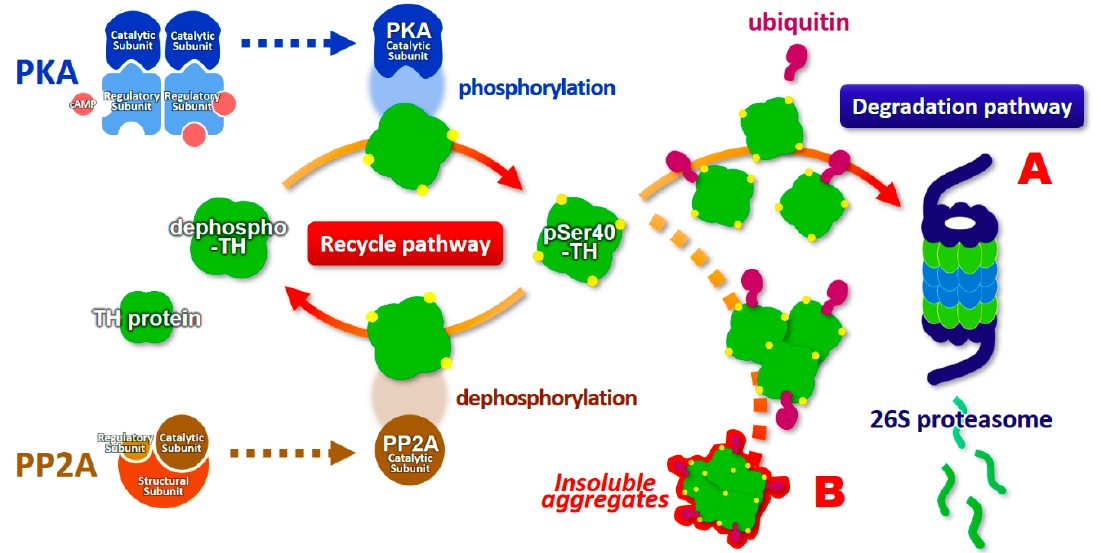
Figure 2. Schematic model of the proteasomal degradation of phosphorylated tyrosine hydroxylase (pSer40-TH). The degradation pathway is indicated in A, and the accumulation pathway to form insoluble aggregates is shown in B. pSer40-TH, tyrosine hydroxylase phosphorylated at serine 40 residue; cAMP, cyclic adenosine monophosphate; PKA, cAMP-dependent protein kinase; PP2A, protein phosphatase 2a.